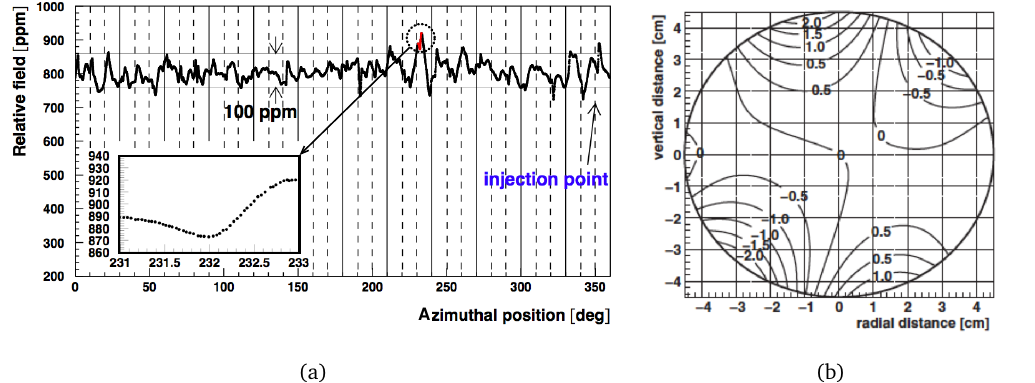
Figure 11: (a) The magnetic dipole field from E821 as a function of azimuth. The inset shows the region circled on an expanded scale. (From Ref. [ 46 ] ) (b) The mag- netic field averaged over azimuth from E821. The contours are 0.5 ppm. (From Ref. [ 46 ]